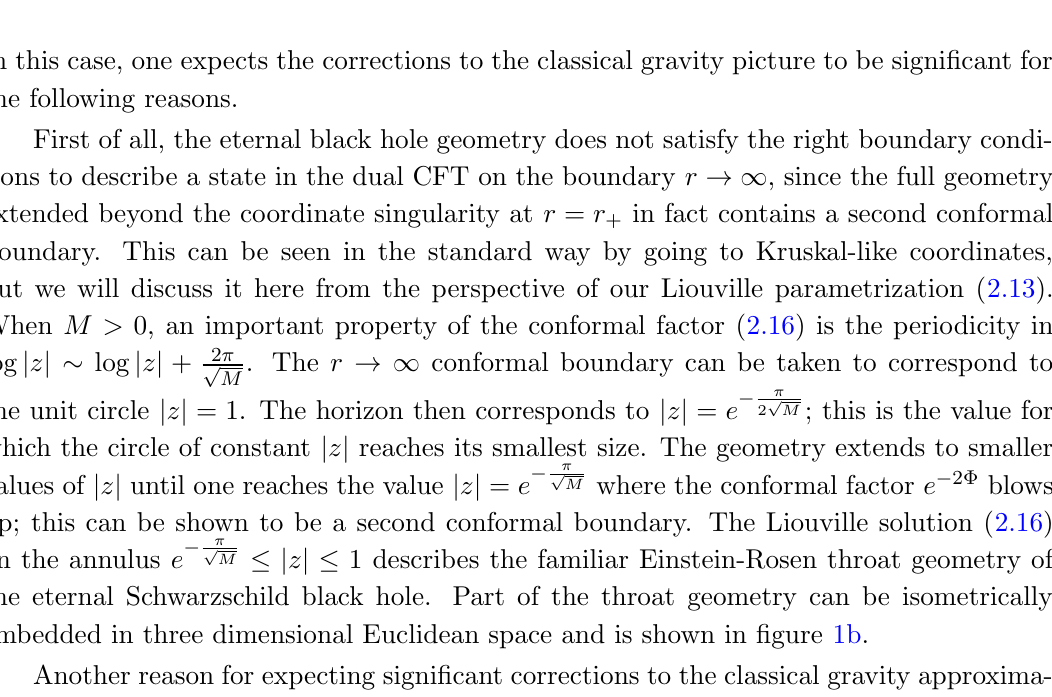
Figure 1 . Embedded spatial geometry of the metric representing (a) a light primary state and (b) a heavy primary above the black hole